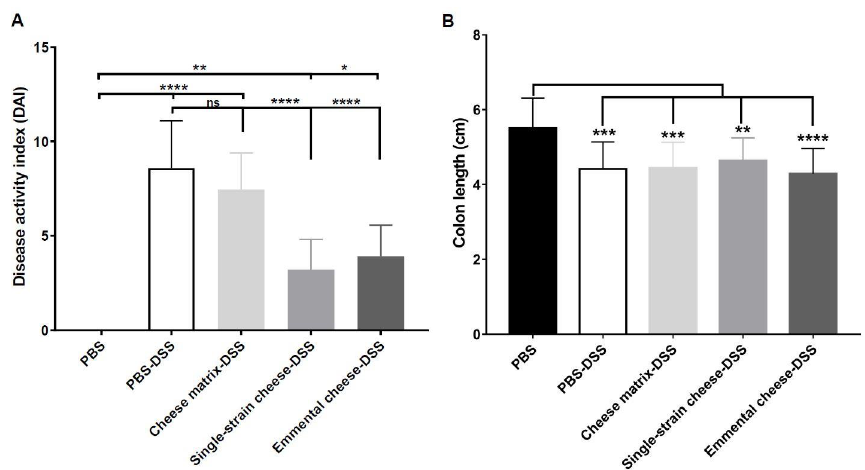
Figure 2. Impact of cheese matrix, single-strain cheese and Emmental cheese on colitis-induced body weight loss. ( A ) Time-course of mice body weight monitoring, and di ff erences across groups. ( B ) Body weight loss observed at the 7th day of DSS colitis induction, and di ff erences across groups. Groups were as follows. PBS: healthy group gavaged using PBS bu ff er as a sham. PBS-DSS: DSS-treated-colitis control group gavaged using PBS bu ff er as a sham. Cheese matrix-DSS: DSS-treated group gavaged using a germ-free dairy matrix. Single-strain cheese-DSS: DSS-treated group gavaged using an experimental single-strain cheese containing P. freudenreichii CIRM-BIA 129 as a sole bacterium. Emmental-DSS: DSS-treated group gavaged using an industrial Emmental cheese produced using P. freudenreichii CIRM-BIA 129 as a ripening starter. The data represent the mean ± SD of 18 mice per group. Multiple comparisons were performed, * p < 0.05, ** p < 0.01, *** p < 0.001 **** p < 0.0001.